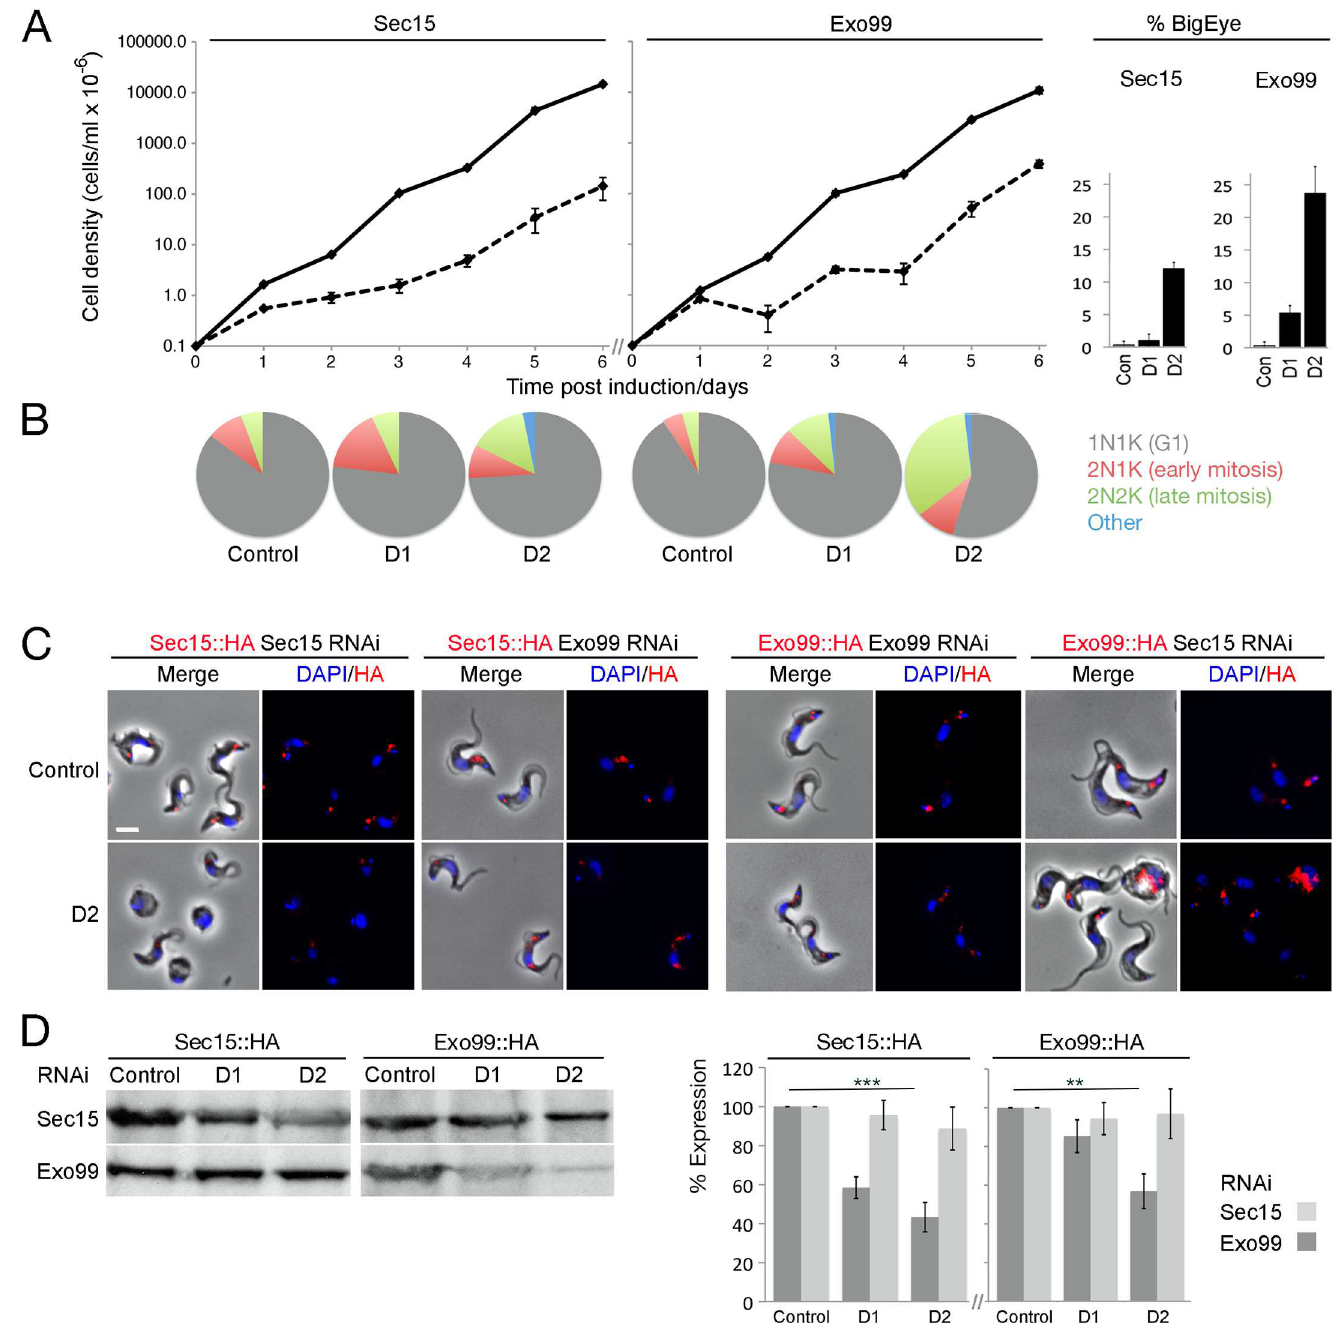
Fig 2. The exocyst is required for cell cycle progression in trypanosomes. (A) Cumulativegrowth curves of uninduced (solid line) and induced (dashedline) Sec15 and Exo99::RNAi lines. Sec15 and Exo99 depletion leads to a severe proliferativedefect, further ~12% and * 25% of Sec15 and Exo99::RNAi cells respectivelyhave an enlargedflagellarpocket by 48h post induction.(B) Cell cycle analysisof Sec15 and Exo99::RNAi cells. For Exo99::RNAi cells a modest disruptionin cell cycle progressionmanifested as an accumulation of 2K2N late-mitotic cells within24 (D1) and48h (D2) post induction;this defect is more severe in Sec15::RNAi cells. Representative result basedon analysisof > 100cells. (C) Immunofluorescencemicroscopy of Sec15 and Exo99 depletionin BSF Sec15::HA andExo99::HA cell lines. Sec15::RNAi cells show a * 50%decreaseof Sec15::HAsignal (red), whilethe relativeexpressionlevel of Exo99 remainsunaltered,and vice versa .DAPI used to visualiseDNA (blue). Scale bar, 5 μ m. N = 50 G1 cells. (D) Western blot of Sec15 and Exo99::RNAi in BSF Sec15::HAand Exo99::HAcell lines. Sec15::RNAi cells have a * 50%decreaseto Sec15::HA48h post induction, whilst expressionof Exo99 remainsstable, and vice versa .N = 3 independentexperiments normalizedto tubulin.Control:SMB cells uninduced; D1: 24 hr post induction;48 hr post induction.